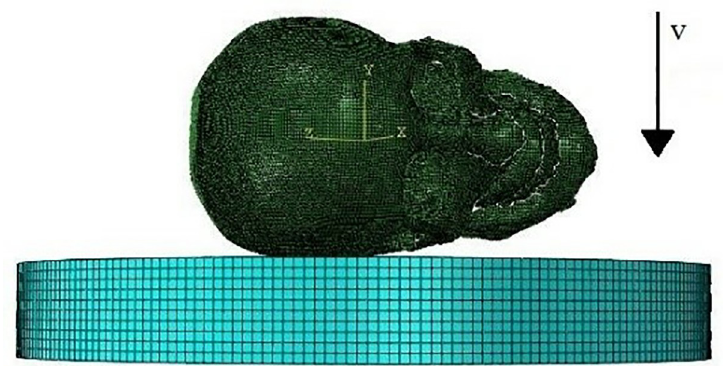
Fig 10. Schematic diagram of impact direction and position in collision